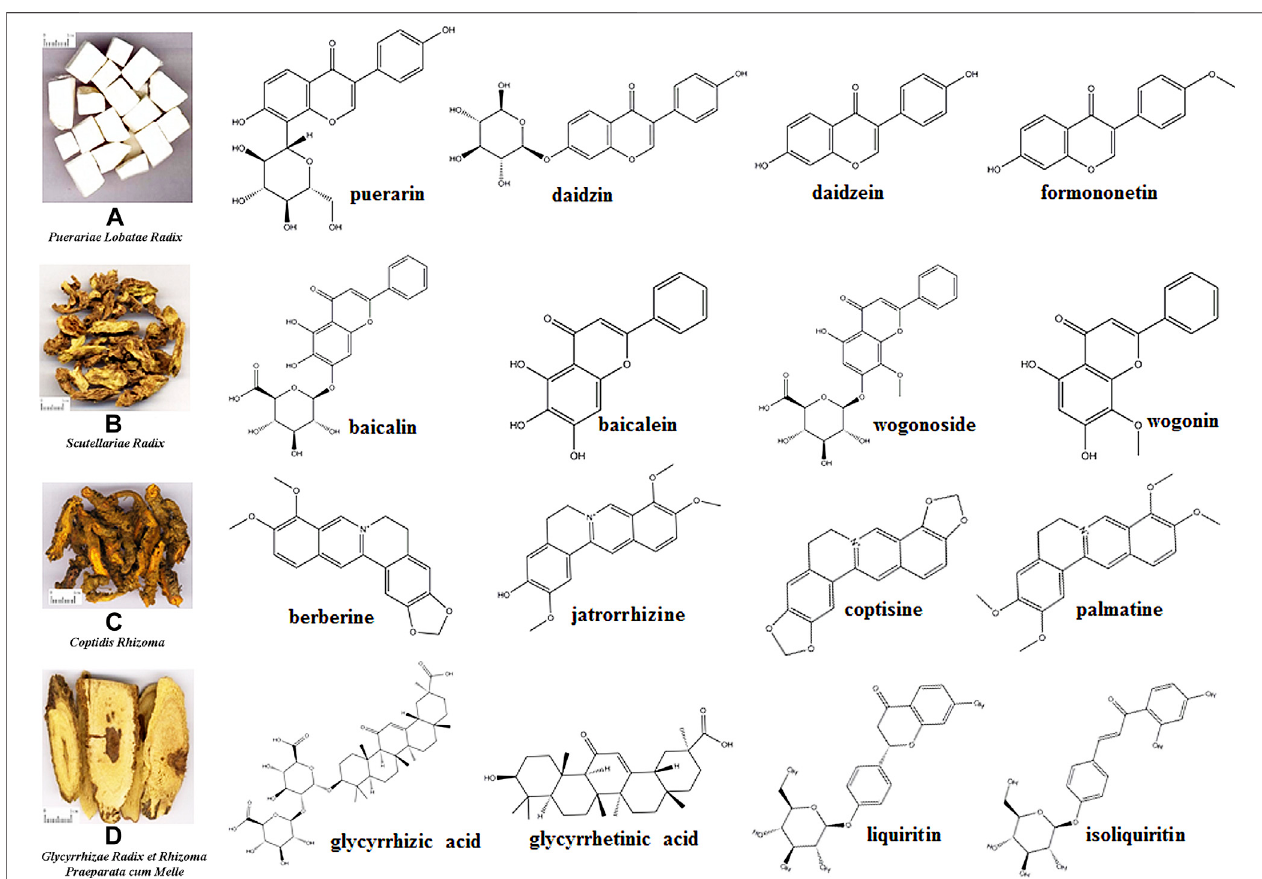
FIGURE 1 | Four traditional Chinese medicines composing Gegen-Qinlian decoction and structures of the main constituents.